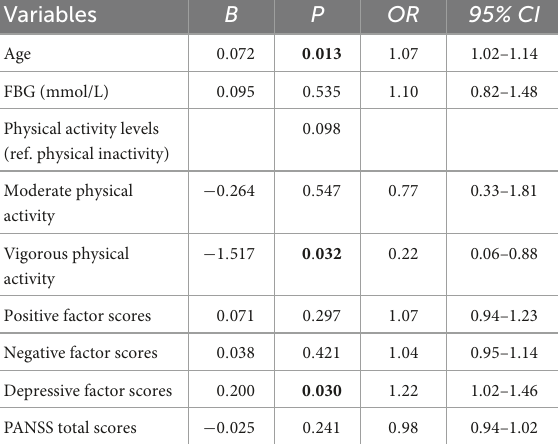
TABLE 2 Correlation analysis of clinical and biological indicators with ISI total scores and HAMD total scores.